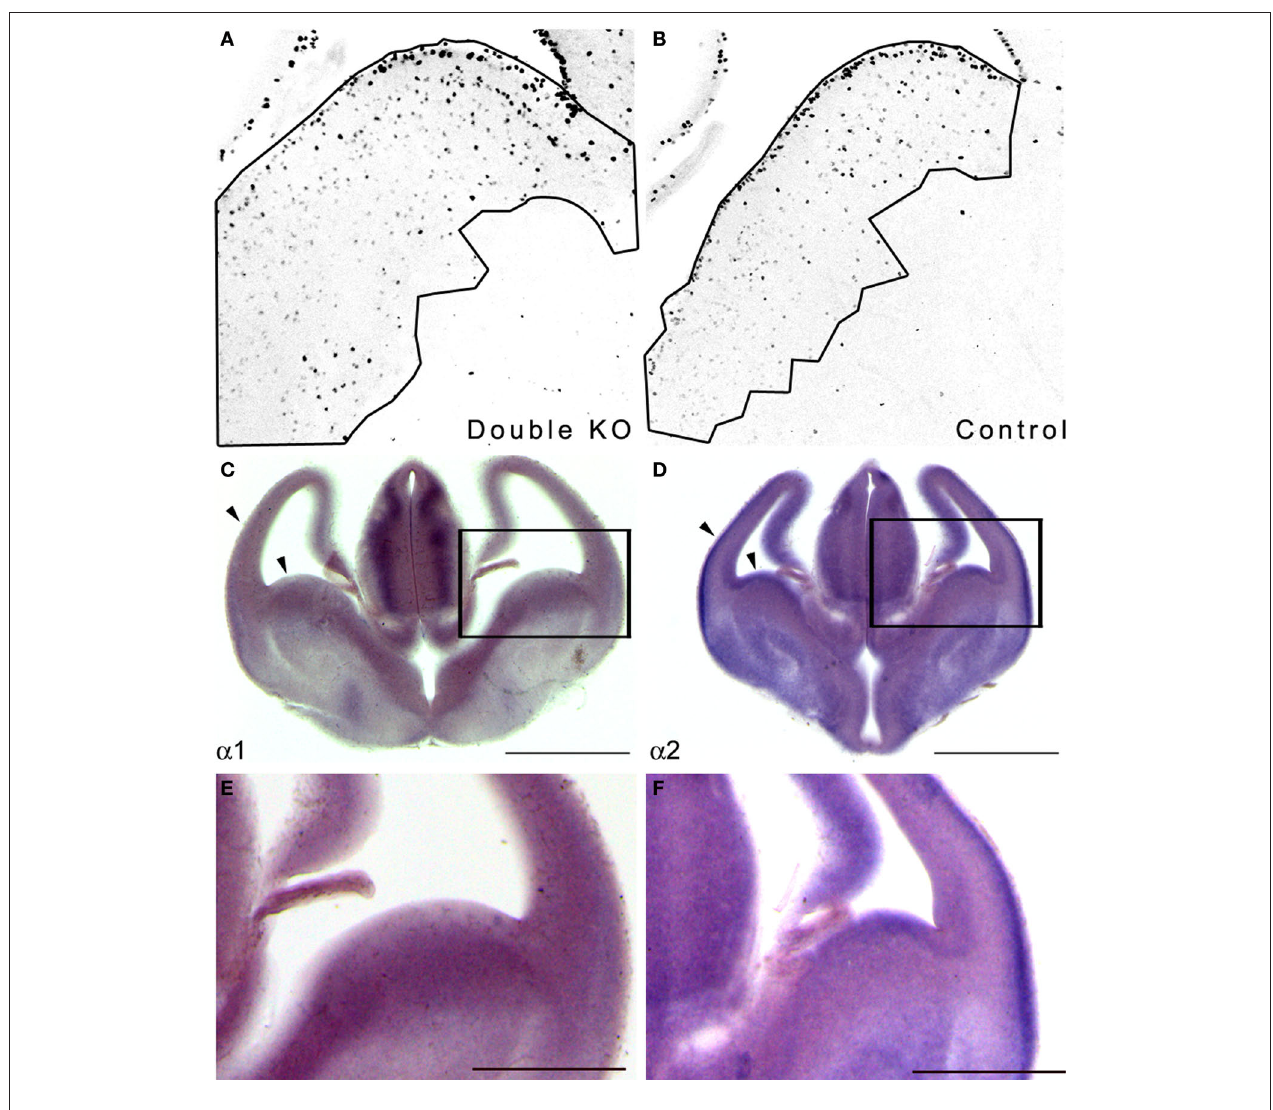
counted. There were more pH3 positive cells in the double KO mice. (C,D) In situ hybridization was conducted at E13.5 using PAF-AH α 1 (C) or α 2 (D) probes. Scale bar is 1 mm. (e,F) High magnification of (C) and (D) , respectively. Scale bar is 0.5